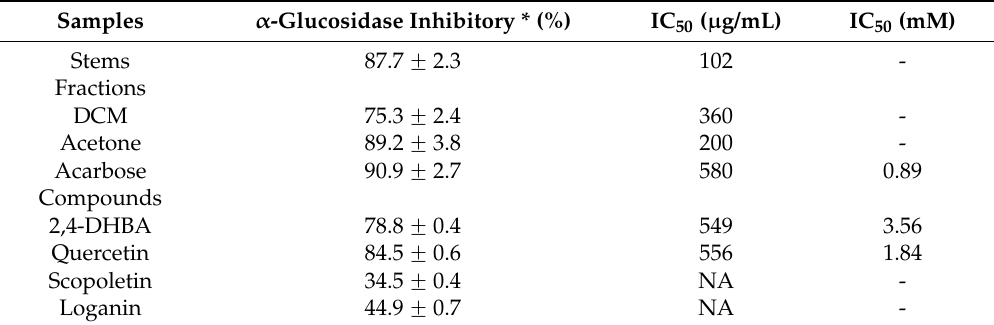
Table 1. α -Glucosidase inhibitory activity of stem extract, fractions and compounds from Uncaria cordata var . ferruginea